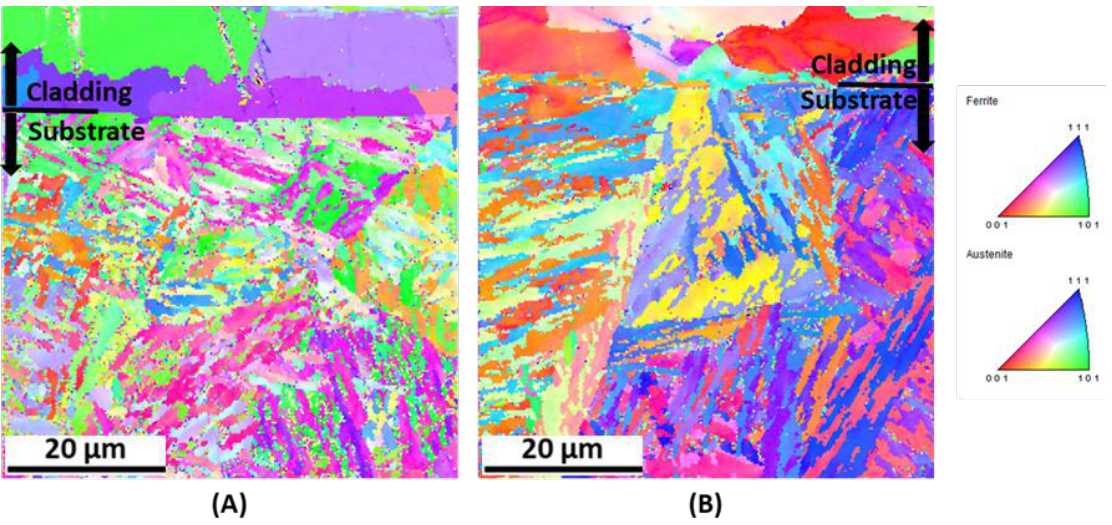
Figure 12. EBSD images of the I2_6_20/substrate interface region. ( A ) Without PHT; ( B ) with PHT.